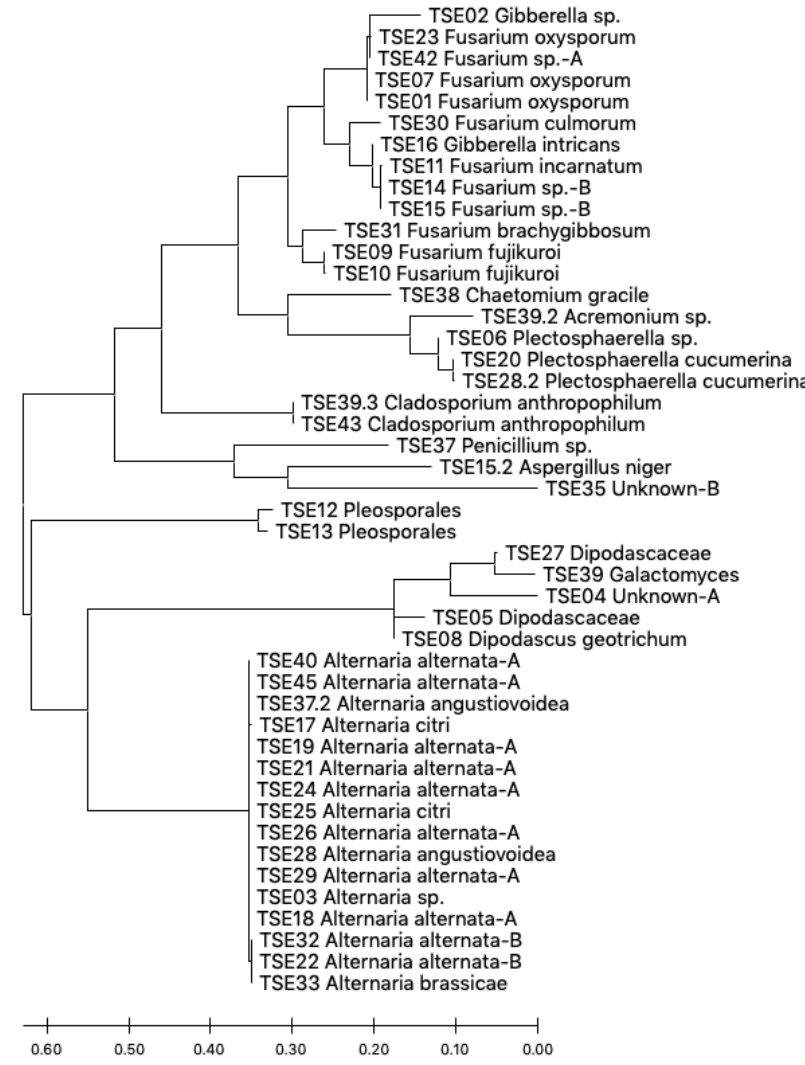
Figure 4. Phylogenetic analysis of the isolated endophyte genera obtained from nature farming tomato plants. The evolutionary history was inferred using the Maximum Likelihood method and Tamura–Nei model [46]. The tree with the highest log likelihood ( − 8023.30) is shown. Initial tree(s) for the heuristic search were obtained automatically by applying Neighbor-Join and BioNJ algorithms to a matrix of pairwise distances estimated using the Maximum Composite Likelihood (MCL) approach, and then selecting the topology with superior log likelihood value. This analysis involved 46 nucleotide sequences. The codon positions included were 1st + 2nd + 3rd + noncoding. There were a total of 1003 positions in the final dataset. Evolutionary analyses were conducted in MEGA X [47]. The “A” or “B” at the end of the taxa name are given to distinguish taxa of the same name with an ITS sequence dissimilarity of >3%.